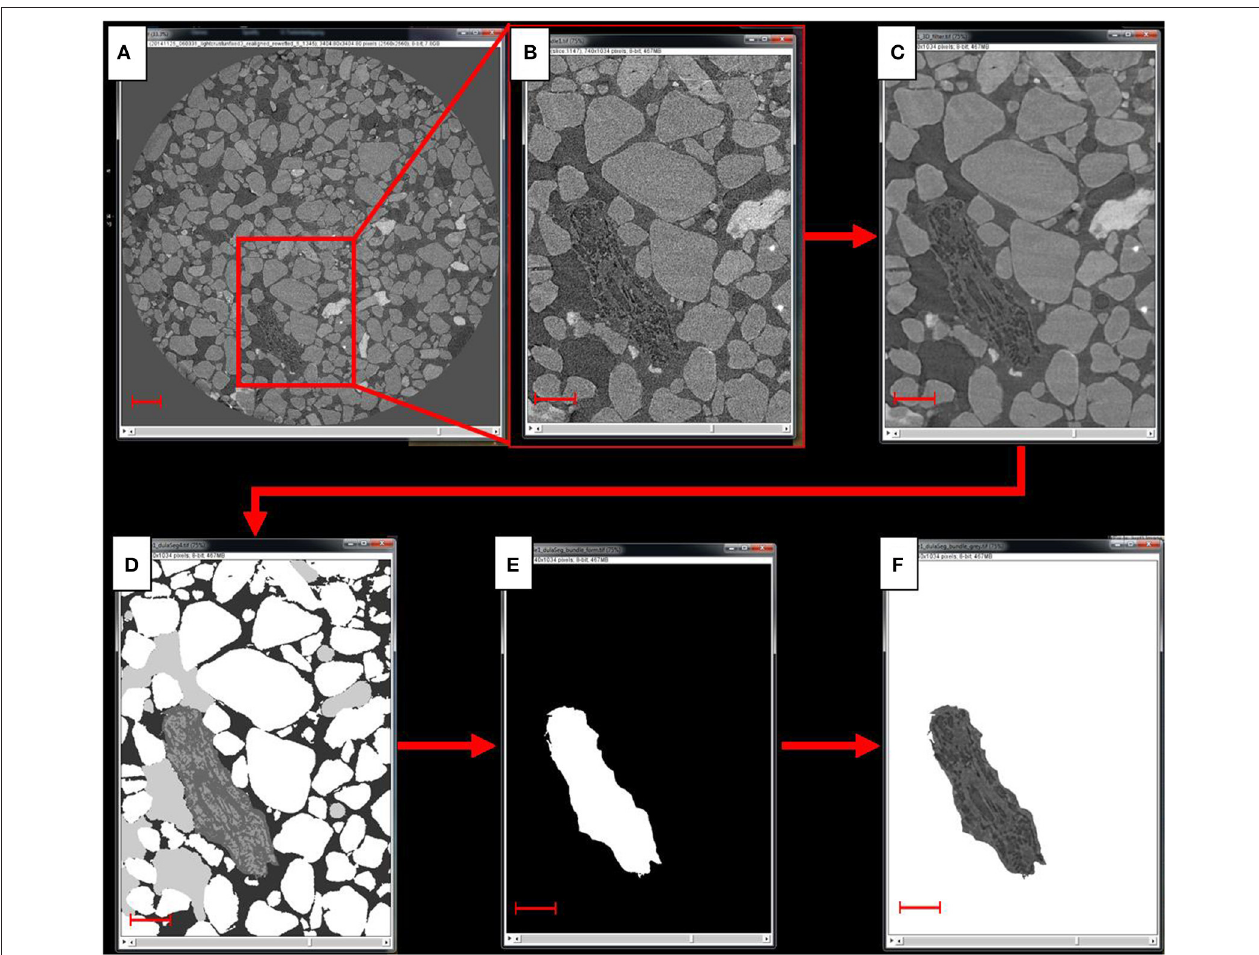
FIGURE 2 | Scheme of the image processing steps. From the reconstructed scan (A) a region of interest, or ROI, containing a large cyanobacterial bundle is cropped out (B) , to which then a 3D median filter is applied to reduce the noise (C) . Next, the image is segmented (D) and the segmented bundle (E) is used as a mask to cop out the bundle from the grayscale image of the ROI (F) . Scale bar in (A) equals 300 µ m, scale bars in (B–F) equal 150 µ